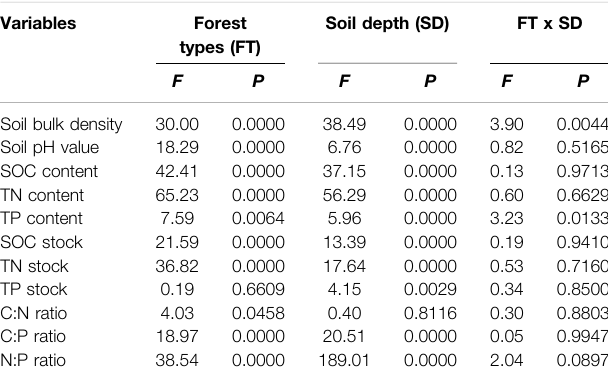
TABLE 3 | Effects ofSD, FT, and theirinteractionon soil properties based on two- way ANOVAs.